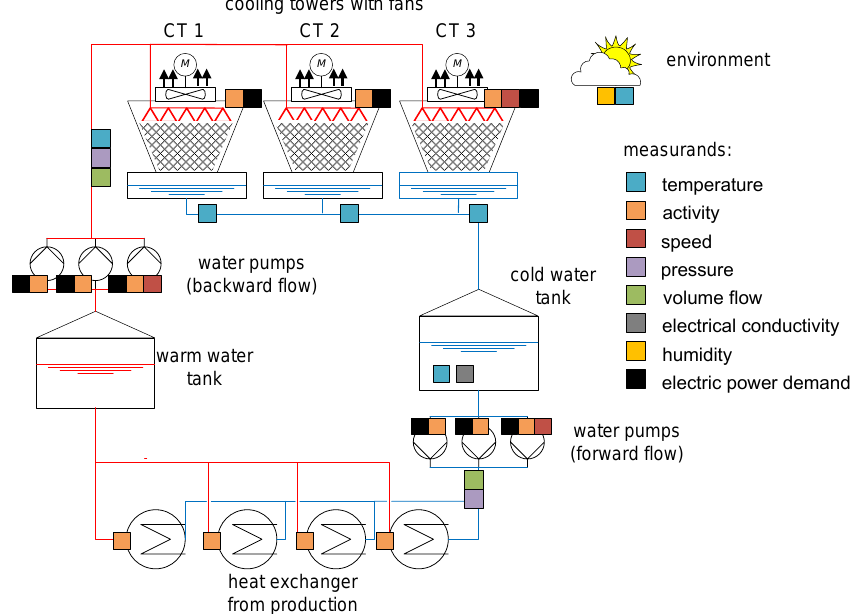
Figure 5. Scheme of considered industrial cooling tower system with relevant measurands.